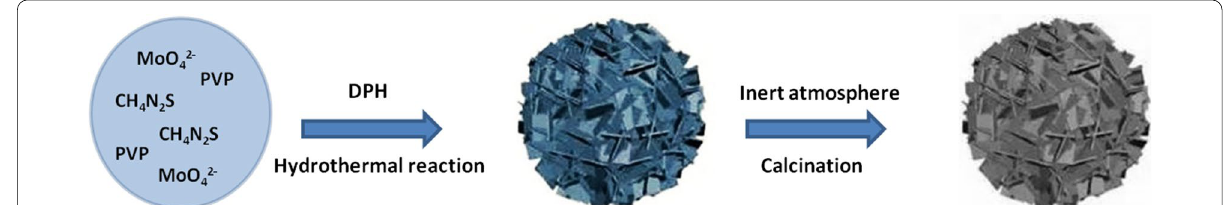
Fig. 1 The preparation process diagram of hierarchical porous MoS 2 /C